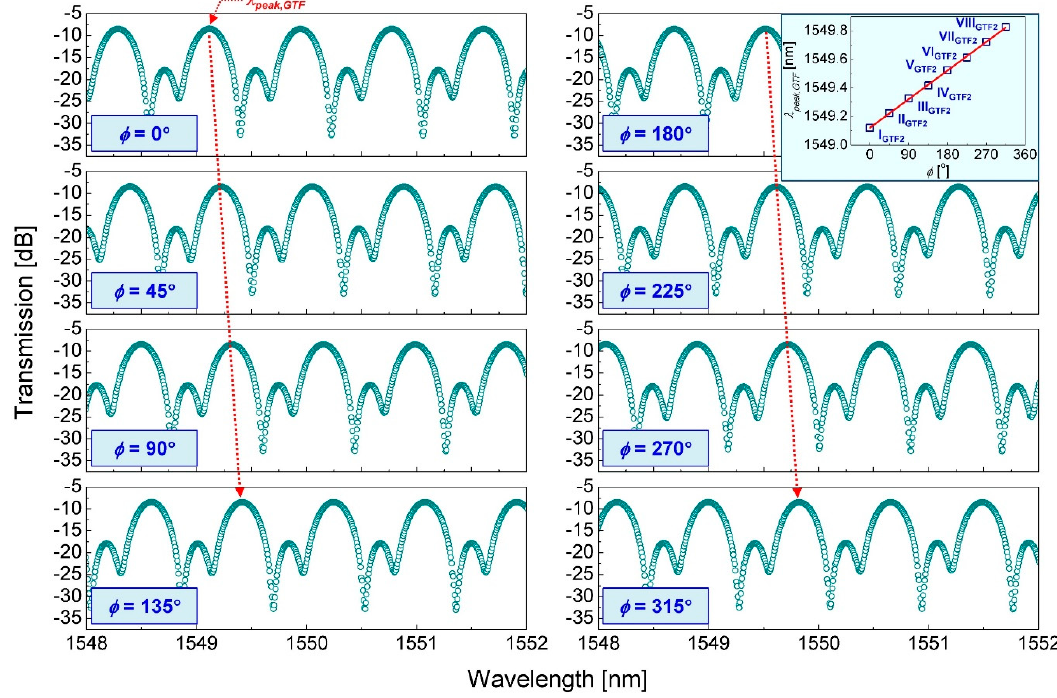
Figure 7. Experimental phase-modulated transmission spectra of GTF ( t GTF 2 ), measured at eight WOA sets (Sets I GTF2 – VIII GTF2 ).